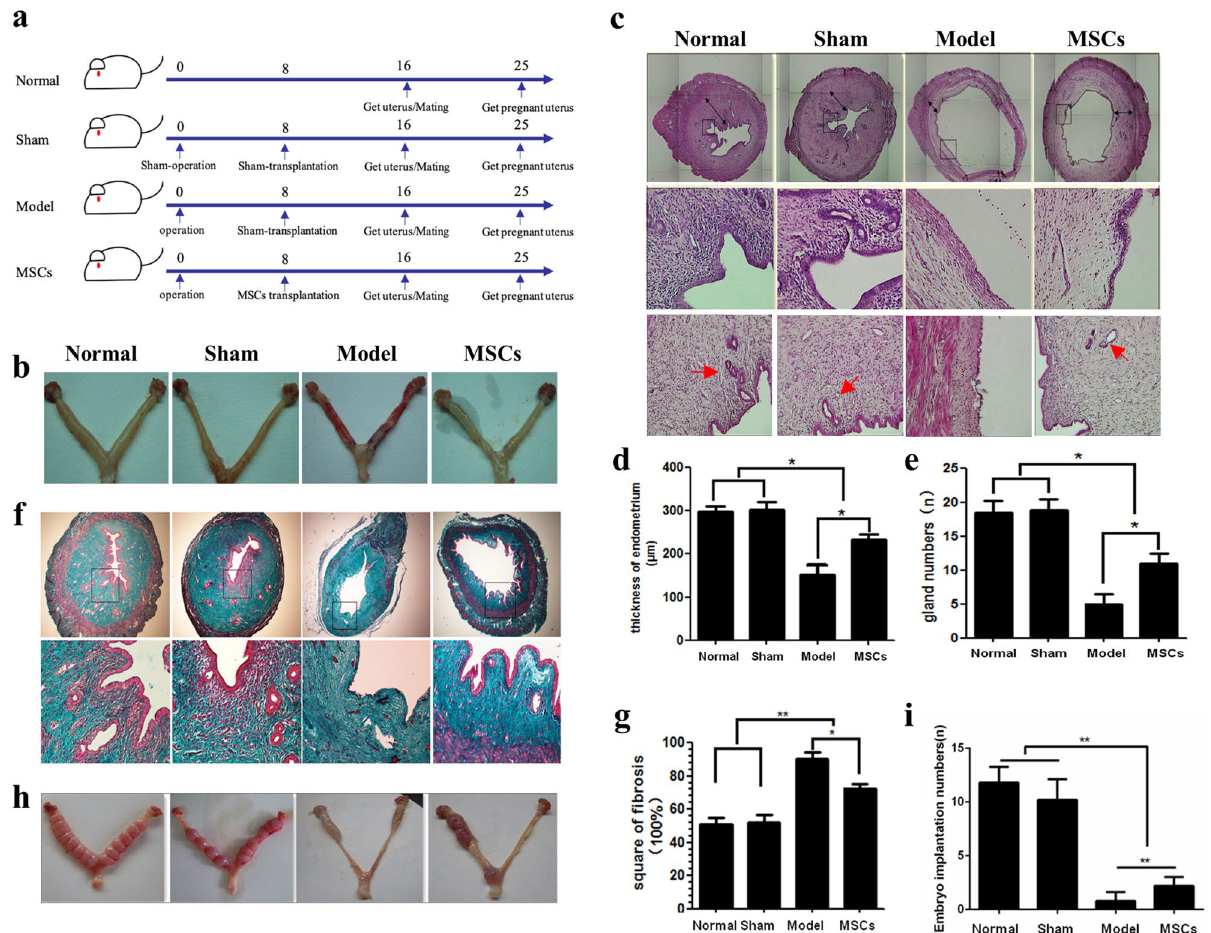
Figure 1. Uterine morphological and functional features and changes. ( a ) Experimental grouping schedule. ( b ) The specimen of uterus. ( c ) The H&E staining of rat uterine tissue (50× and 200×). The red arrow indicates the glands. ( d ) Statistical analysis of endometrial thickness. ( e ) Statistical analysis of gland numbers. ( f ) The Masson staining of rat uterine tissue (50× and 200×). ( g ) Statistical analysis of endometrial fibrosis. ( h ) The specimen of embryos implanted in the uterus. ( i ) Statistical analysis of embryos implanted numbers. * p < 0.05, ** p <